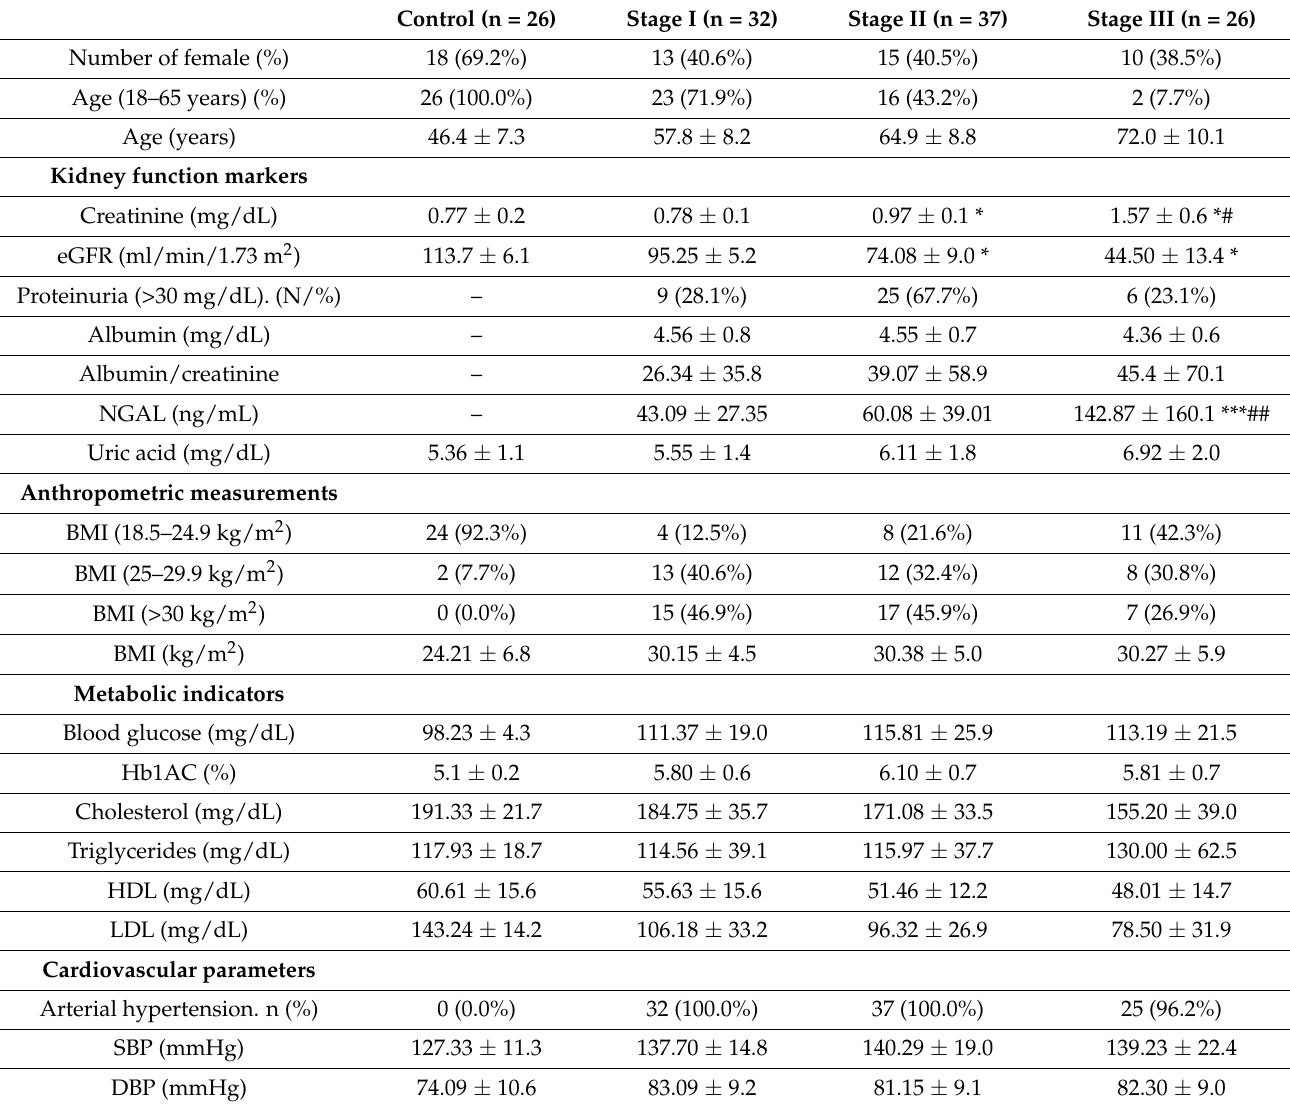
Table 1. Demographic